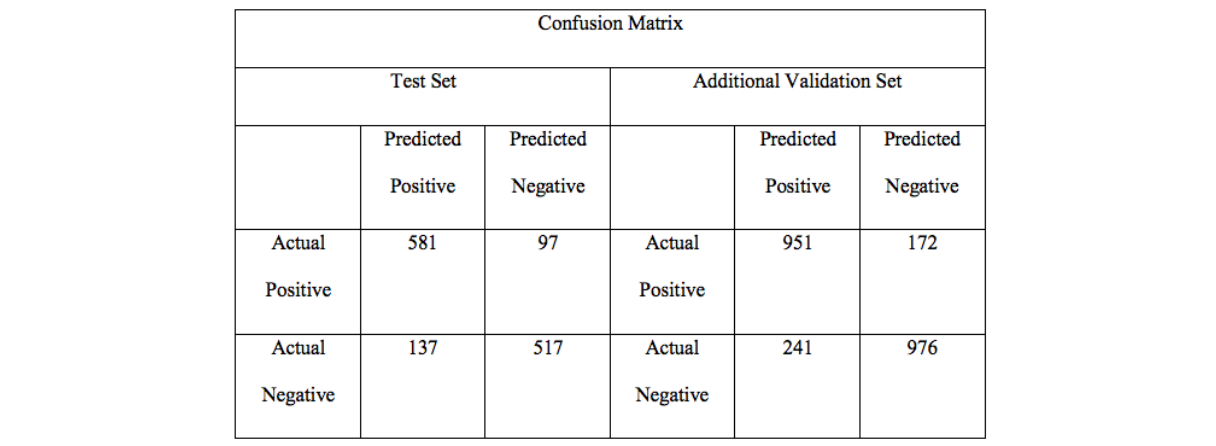
Figure 3. Confusion matrix for the test set and the additional validation